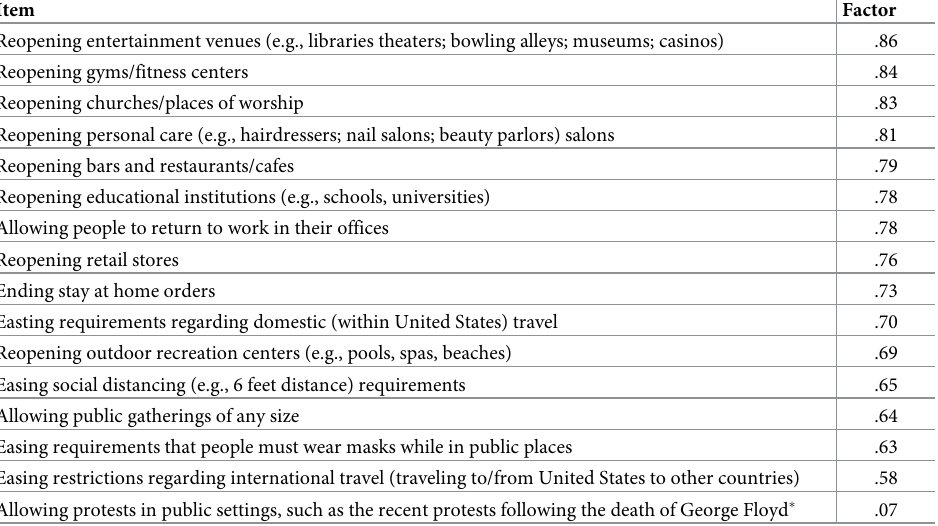
Table 3. Item loadings for a forced single-factor model for specific attitudes to easing COVID-19 restrictions items using Principal Axis